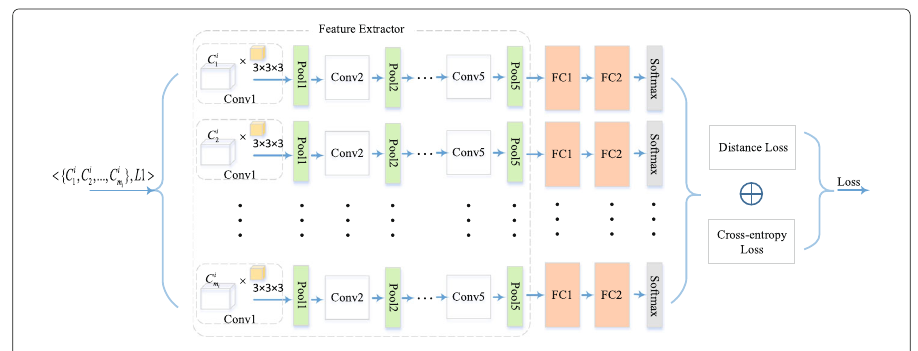
Fig. 3 The structure of the proposed